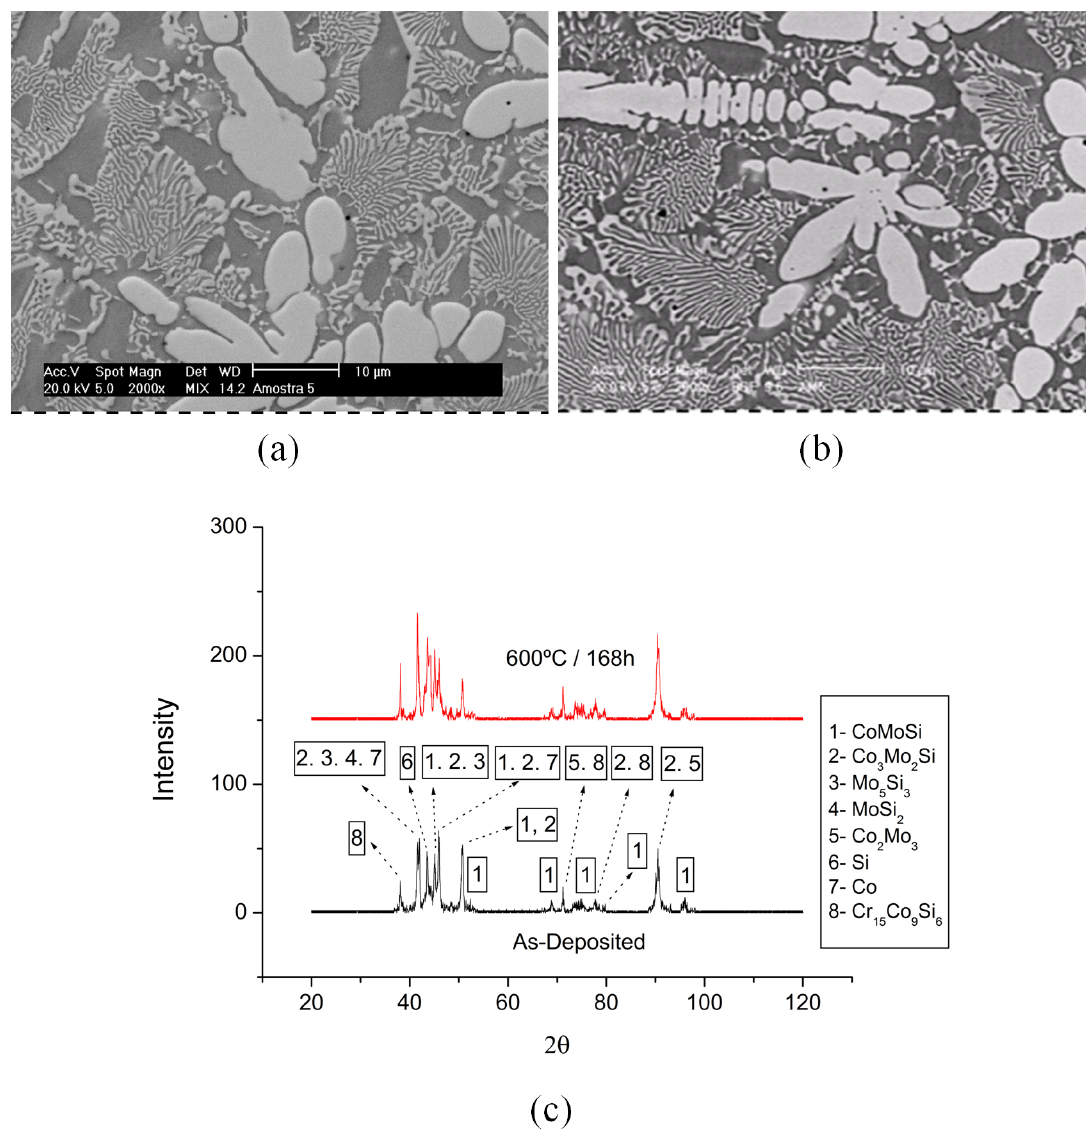
Figure 4. Microstructure of the Coating CoCrMoSi alloy (a), exposed to 600 °C for 168h (b) and no new phase formed after exposition